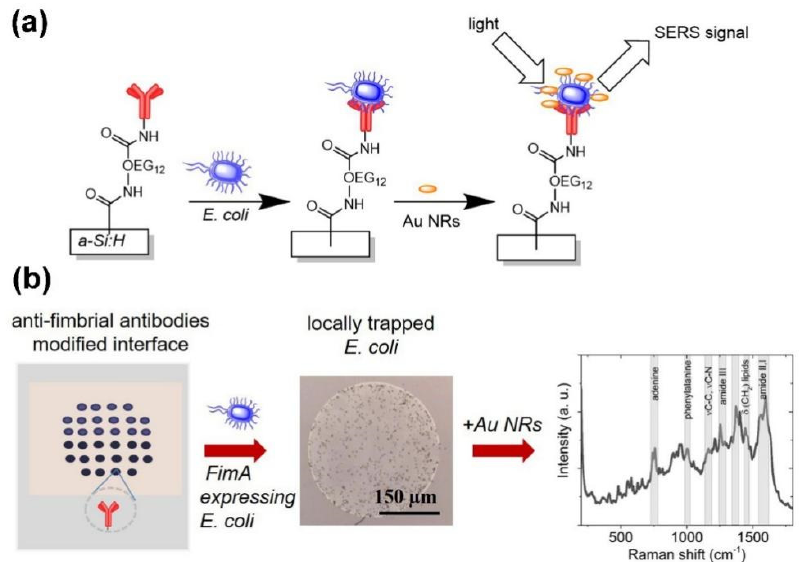
Figure 3. Schematic detection principle of E. coli hydrogenated amorphous silicon a-Si:H surface modified with anti-fimbrial antibodies against the major pilin protein fimA. ( a ) Surface structures of E. coli expressing fimA selectively captured and positively charged Au-NRs incubated with E. coli for SERS sensing. ( b ) Anti-fimbriae modified array, optical imaging of spots after interaction with E. coli and SERS spectra after capturing bacteria [97]. Adapted with permission from Ref. [97]. Copyright © 2020 Elsevier B.V.